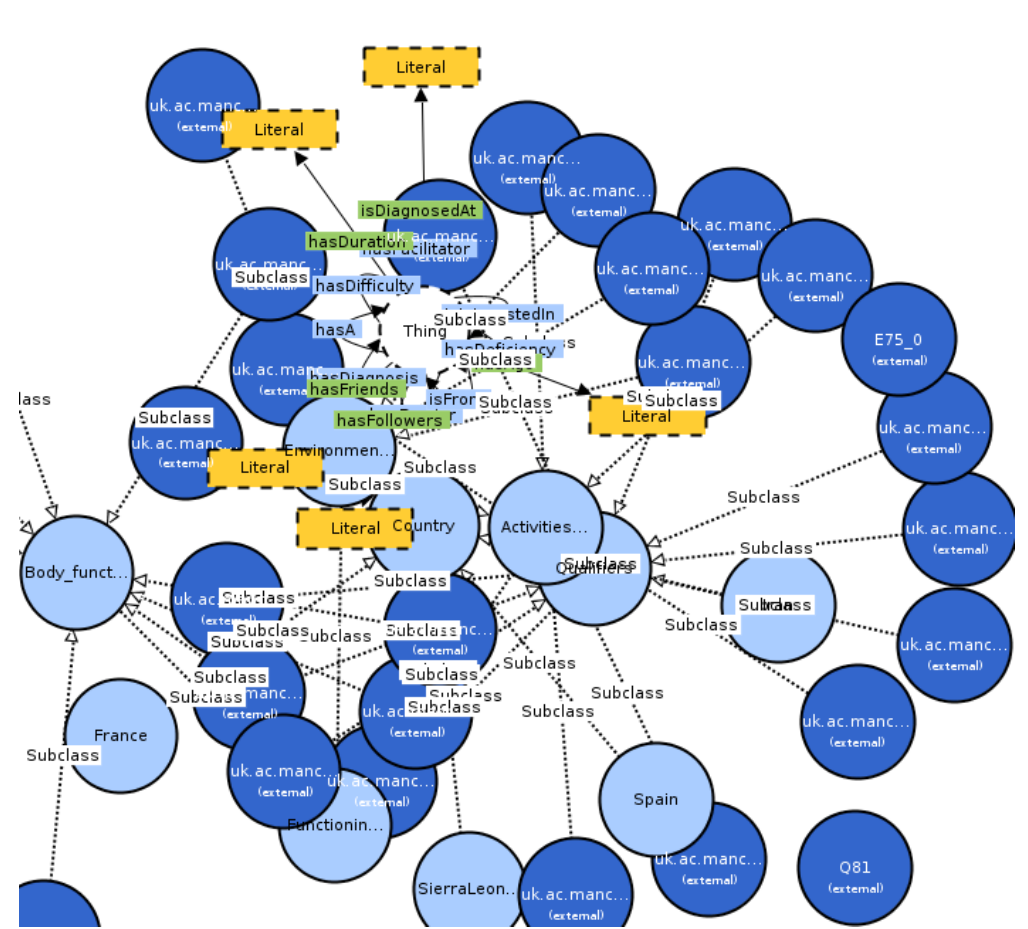
Figure 2. Partial Visual Notation for OWL Ontologies (VOWL) representation of the proposed